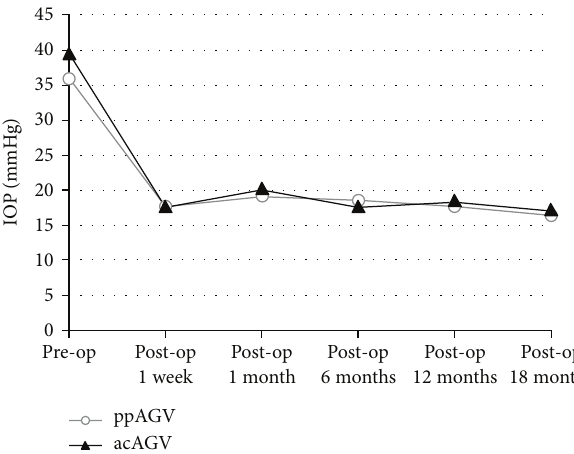
Figure2:Meanintraocularpressureafterinparsplanaimplantation and anterior chamber implantation of Ahmed glaucoma valve